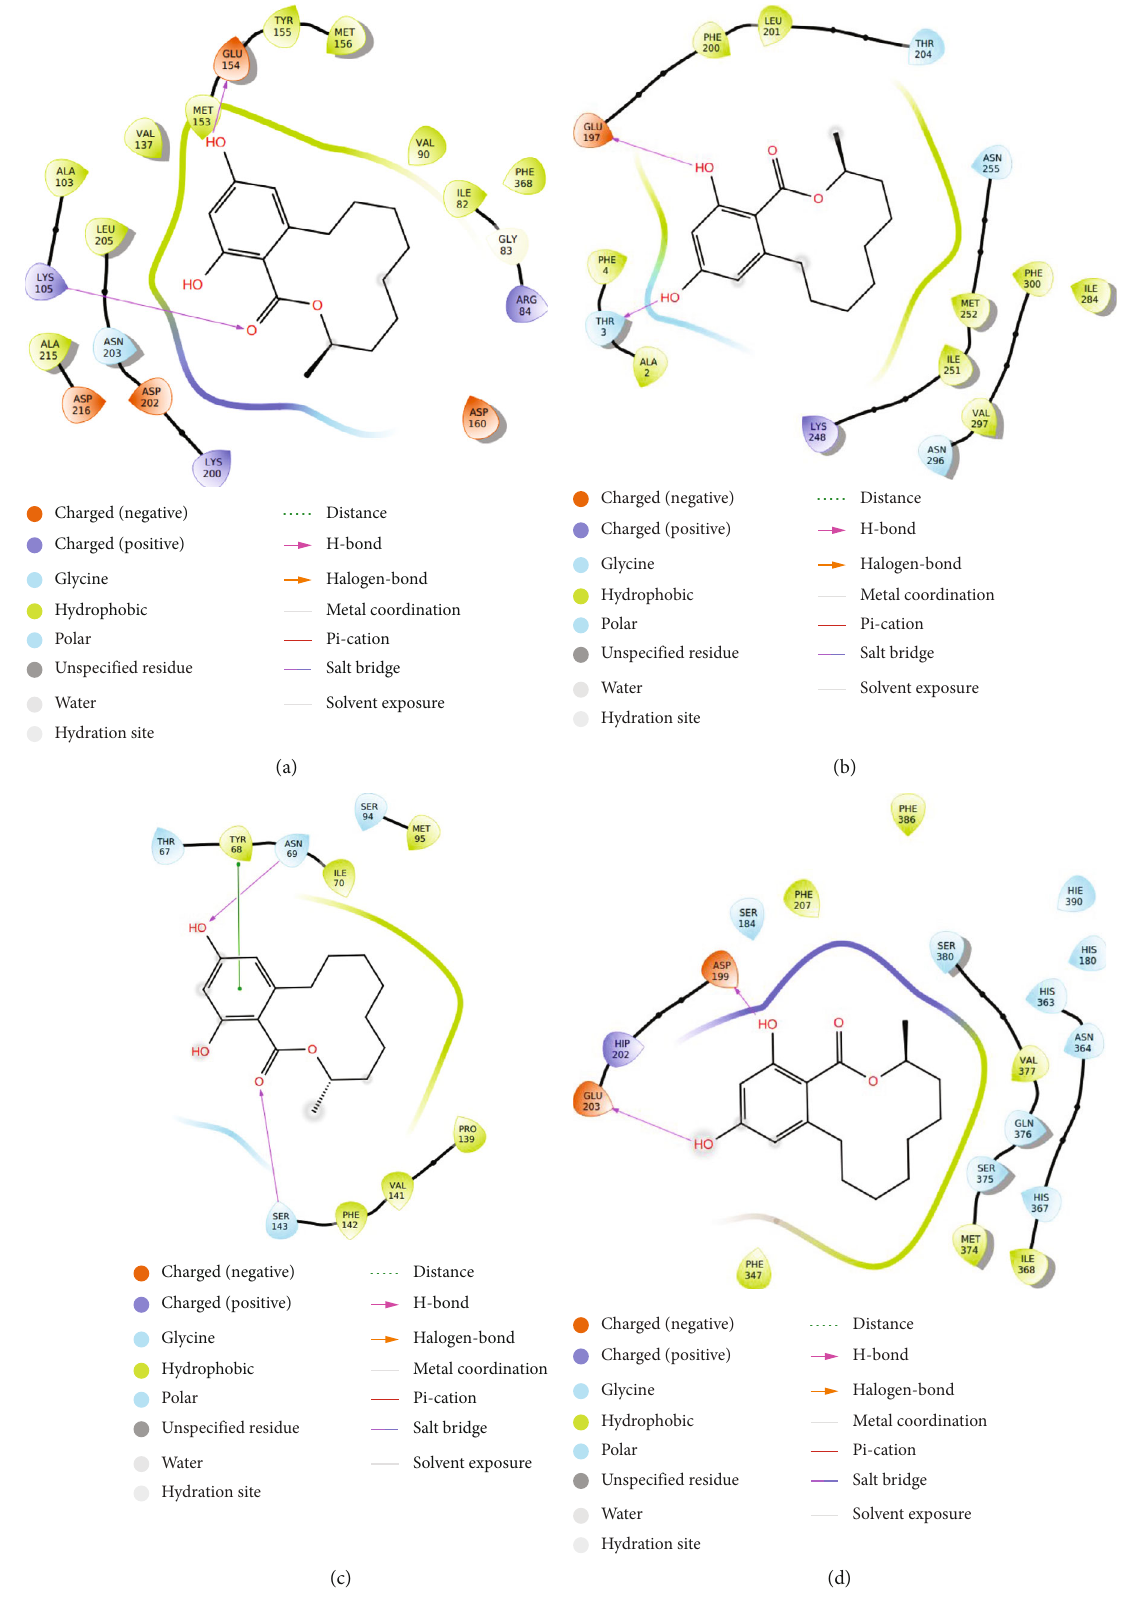
Figure 3: The 2D interactions of compound 1 with (a) 2ETR (b) 3C3R (c) 3OBQ, and (d) tyrosinase